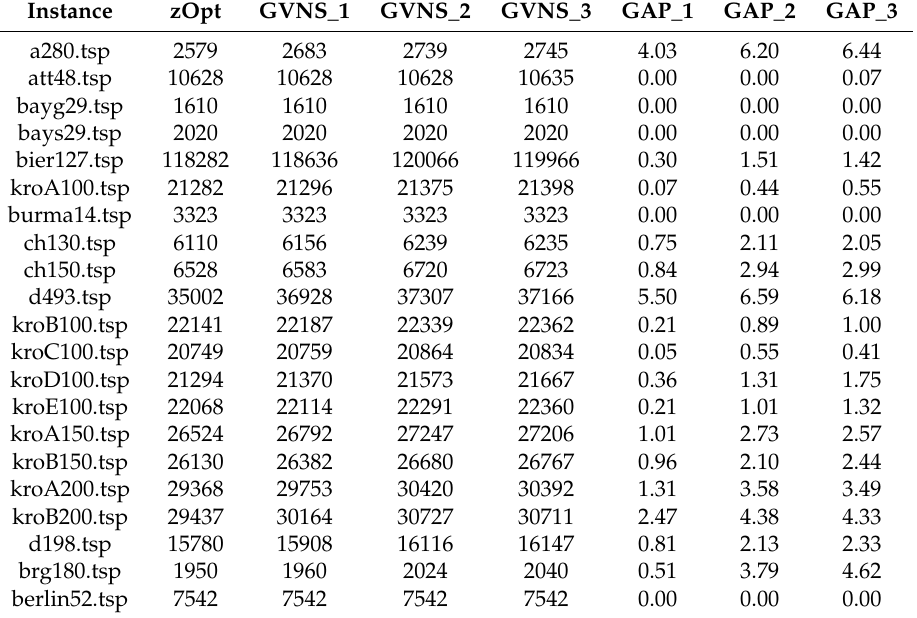
Table 5. Results using the First Improvement search strategy and an execution time limit of 1